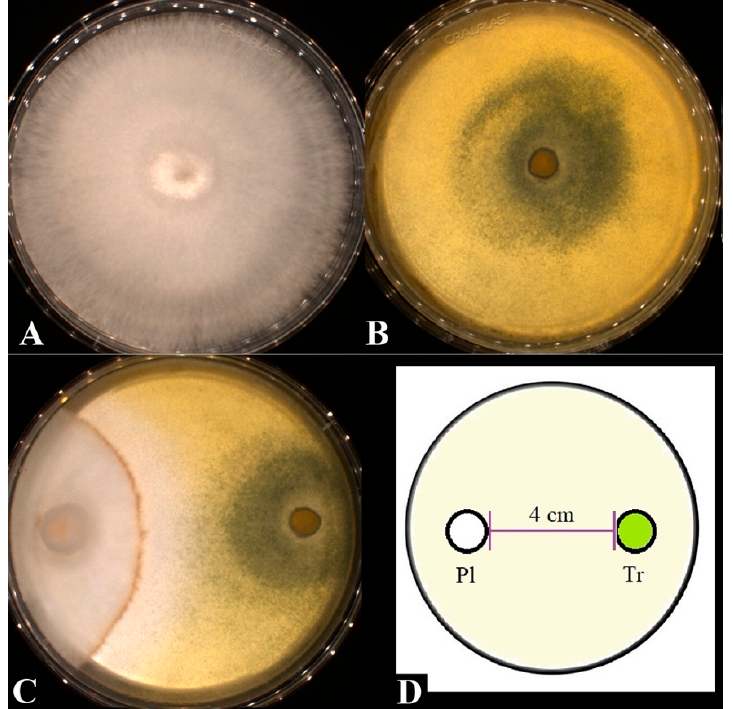
Figure 1. The growth pattern of P. lecomtei BRM 044603 (Pl) ( A ) and T. reesei ATCC 56765 (Tr) ( B ), and their growth interaction ( C ) on potato dextrose agar (PDA) plates after 8 days at 28 °C. The growth interaction was carried out by placing the mycelial disc of both fungi on the same plate, separated by 4 cm ( D